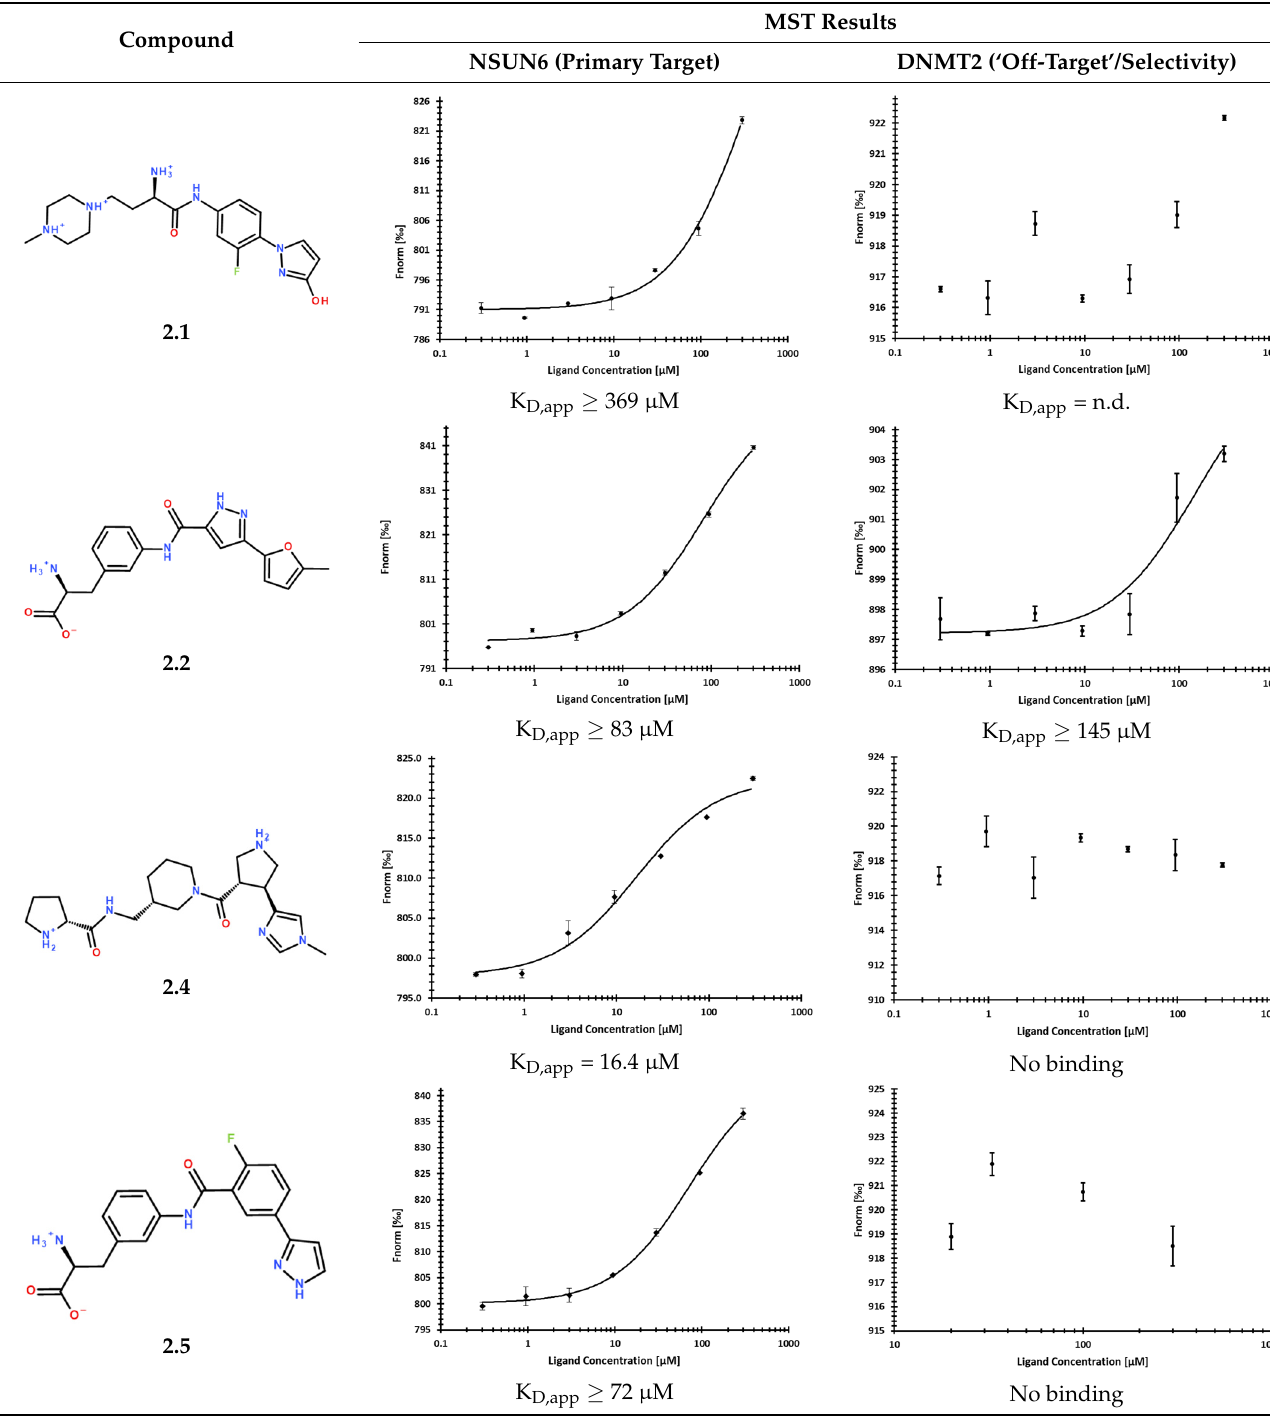
Table 3. MST results of newly identified NSUN6-ligands derived from the NSUN6 virtual screening. Table 3. MST results of newly identi fi ed NSUN6-ligands derived from the NSUN6 virtual screening. Table 3. MST results of newly identi fi ed NSUN6-ligands derived from the NSUN6 virtual screening. Table 3. MST results of newly identi fi ed NSUN6-ligands derived from the NSUN6 virtual screening. Table 3. MST results of newly identi fi ed NSUN6-ligands derived from the NSUN6 virtual screening. Table 3. MST results of newly identi fi ed NSUN6-ligands derived from the NSUN6 virtual screening. Table 3. MST results of newly identi fi ed NSUN6-ligands derived from the NSUN6 virtual screening. Measured normalized fluorescence values (Fnorm [‰]) are mean with standard error of at least Table 3. MST results of newly identi fi ed NSUN6-ligands derived from the NSUN6 virtual screening. Table 3. MST results of newly identi fi ed NSUN6-ligands derived from the NSUN6 virtual screening. Table 3. MST results of newly identi fi ed NSUN6-ligands derived from the NSUN6 virtual screening. Table 3. MST results of newly identi fi ed NSUN6-ligands derived from the NSUN6 virtual screening. Table 3. MST results of newly identi fi ed NSUN6-ligands derived from the NSUN6 virtual screening. Table 3. MST results of newly identi fi ed NSUN6-ligands derived from the NSUN6 virtual screening. Measured normalized fl uorescence values (Fnorm [‰]) are mean with standard error of at least Measured normalized fl uorescence values (Fnorm [‰]) are mean with standard error of at least Measured normalized fl uorescence values (Fnorm [‰]) are mean with standard error of at least Measured normalized fl uorescence values (Fnorm [‰]) are mean with standard error of at least Measured normalized fl uorescence values (Fnorm [‰]) are mean with standard error of at least Measured normalized fl uorescence values (Fnorm [‰]) are mean with standard error of at least duplicate determination. Apparent K D values (K D,app ) are indicated as a lower limit (via the ≥ Measured normalized fl uorescence values (Fnorm [‰]) are mean with standard error of at least Measured normalized fl uorescence values (Fnorm [‰]) are mean with standard error of at least Measured normalized fl uorescence values (Fnorm [‰]) are mean with standard error of at least Measured normalized fl uorescence values (Fnorm [‰]) are mean with standard error of at least Measured normalized fl uorescence values (Fnorm [‰]) are mean with standard error of at least Measured normalized fl uorescence values (Fnorm [‰]) are mean with standard error of at least duplicate determination. Apparent K D values (K D,app ) are indicated as a lower limit (via the ≥ symbol) duplicate determination. Apparent K D values (K D,app ) are indicated as a lower limit (via the ≥ symbol) duplicate determination. Apparent K D values (K D,app ) are indicated as a lower limit (via the ≥ symbol) duplicate determination. Apparent K D values (K D,app ) are indicated as a lower limit (via the ≥ symbol) duplicate determination. Apparent K D values (K D,app ) are indicated as a lower limit (via the ≥ symbol) duplicate determination. Apparent K D values (K D,app ) are indicated as a lower limit (via the ≥ symbol) duplicate determination. Apparent K D values (K D,app ) are indicated as a lower limit (via the ≥ symbol) duplicate determination. Apparent K D values (K D,app ) are indicated as a lower limit (via the ≥ symbol) duplicate determination. Apparent K D values (K D,app ) are indicated as a lower limit (via the ≥ symbol) symbol) if the upper plateau of the dose–response curve was not completely reached. In case a duplicate determination. Apparent K D values (K D,app ) are indicated as a lower limit (via the ≥ symbol) duplicate determination. Apparent K D values (K D,app ) are indicated as a lower limit (via the ≥ symbol) duplicate determination. Apparent K D values (K D,app ) are indicated as a lower limit (via the ≥ symbol) if the upper plateau of the dose–response curve was not completely reached. In case a dose-depend- if the upper plateau of the dose–response curve was not completely reached. In case a dose-depend- if the upper plateau of the dose–response curve was not completely reached. In case a dose-depend- if the upper plateau of the dose–response curve was not completely reached. In case a dose-depend- if the upper plateau of the dose–response curve was not completely reached. In case a dose-depend- if the upper plateau of the dose–response curve was not completely reached. In case a dose-depend- if the upper plateau of the dose–response curve was not completely reached. In case a dose-depend- if the upper plateau of the dose–response curve was not completely reached. In case a dose-depend- if the upper plateau of the dose–response curve was not completely reached. In case a dose-depend- dose-dependent shift in thermophoresis was observed, which indicates binding, but the curve could if the upper plateau of the dose–response curve was not completely reached. In case a dose-depend- if the upper plateau of the dose–response curve was not completely reached. In case a dose-depend- if the upper plateau of the dose–response curve was not completely reached. In case a dose-depend- ent shift in thermophoresis was observed, which indicates binding, but the curve could not be fi tt ed ent shift in thermophoresis was observed, which indicates binding, but the curve could not be fi tt ed ent shift in thermophoresis was observed, which indicates binding, but the curve could not be fi tt ed ent shift in thermophoresis was observed, which indicates binding, but the curve could not be fi tt ed ent shift in thermophoresis was observed, which indicates binding, but the curve could not be fi tt ed ent shift in thermophoresis was observed, which indicates binding, but the curve could not be fi tt ed ent shift in thermophoresis was observed, which indicates binding, but the curve could not be fi tt ed ent shift in thermophoresis was observed, which indicates binding, but the curve could not be fi tt ed ent shift in thermophoresis was observed, which indicates binding, but the curve could not be fi tt ed ent shift in thermophoresis was observed, which indicates binding, but the curve could not be fi tt ed ent shift in thermophoresis was observed, which indicates binding, but the curve could not be fi tt ed ent shift in thermophoresis was observed, which indicates binding, but the curve could not be fi tt ed not be fitted with sufficient accuracy, K D,app was not determined (n.d.). Molecules are depicted in with su ffi cient accuracy, K D,app was not determined (n.d.). Molecules are depicted in their docked with su ffi cient accuracy, K D,app was not determined (n.d.). Molecules are depicted in their docked with su ffi cient accuracy, K D,app was not determined (n.d.). Molecules are depicted in their docked with su ffi cient accuracy, K D,app was not determined (n.d.). Molecules are depicted in their docked with su ffi cient accuracy, K D,app was not determined (n.d.). Molecules are depicted in their docked with su ffi cient accuracy, K D,app was not determined (n.d.). Molecules are depicted in their docked with su ffi cient accuracy, K D,app was not determined (n.d.). Molecules are depicted in their docked with su ffi cient accuracy, K D,app was not determined (n.d.). Molecules are depicted in their docked with su ffi cient accuracy, K D,app was not determined (n.d.). Molecules are depicted in their docked with su ffi cient accuracy, K D,app was not determined (n.d.). Molecules are depicted in their docked with su ffi cient accuracy, K D,app was not determined (n.d.). Molecules are depicted in their docked with su ffi cient accuracy, K D,app was not determined (n.d.). Molecules are depicted in their docked their docked stereoisomers, protomers, and tautomers; however, for 2.1 and 2.4 , racemic mixtures stereoisomers, protomers, and tautomers; however, for 2.1 and 2.4 , racemic mixtures were obtained stereoisomers, protomers, and tautomers; however, for 2.1 and 2.4 , racemic mixtures were obtained stereoisomers, protomers, and tautomers; however, for 2.1 and 2.4 , racemic mixtures were obtained stereoisomers, protomers, and tautomers; however, for 2.1 and 2.4 , racemic mixtures were obtained stereoisomers, protomers, and tautomers; however, for 2.1 and 2.4 , racemic mixtures were obtained stereoisomers, protomers, and tautomers; however, for 2.1 and 2.4 , racemic mixtures were obtained stereoisomers, protomers, and tautomers; however, for 2.1 and 2.4 , racemic mixtures were obtained stereoisomers, protomers, and tautomers; however, for 2.1 and 2.4 , racemic mixtures were obtained stereoisomers, protomers, and tautomers; however, for 2.1 and 2.4 , racemic mixtures were obtained stereoisomers, protomers, and tautomers; however, for 2.1 and 2.4 , racemic mixtures were obtained stereoisomers, protomers, and tautomers; however, for 2.1 and 2.4 , racemic mixtures were obtained stereoisomers, protomers, and tautomers; however, for 2.1 and 2.4 , racemic mixtures were obtained for testing. All molecules are drawn in the same orientation as SAH, with left side: amino acid mi- for testing. All molecules are drawn in the same orientation as SAH, with left side: amino acid mi- for testing. All molecules are drawn in the same orientation as SAH, with left side: amino acid mi- were obtained for testing. All molecules are drawn in the same orientation as SAH, with left side: for testing. All molecules are drawn in the same orientation as SAH, with left side: amino acid mi- for testing. All molecules are drawn in the same orientation as SAH, with left side: amino acid mi- for testing. All molecules are drawn in the same orientation as SAH, with left side: amino acid mi- for testing. All molecules are drawn in the same orientation as SAH, with left side: amino acid mi- for testing. All molecules are drawn in the same orientation as SAH, with left side: amino acid mi- for testing. All molecules are drawn in the same orientation as SAH, with left side: amino acid mi- for testing. All molecules are drawn in the same orientation as SAH, with left side: amino acid mi- for testing. All molecules are drawn in the same orientation as SAH, with left side: amino acid mi- for testing. All molecules are drawn in the same orientation as SAH, with left side: amino acid mi- metic, central part: ribose replacement, right side: adenine mimetic. metic, central part: ribose replacement, right side: adenine mimetic. metic, central part: ribose replacement, right side: adenine metic, central part: ribose replacement, right side: adenine mimetic. amino acid mimetic, central part: ribose replacement, right side: adenine mimetic. metic, central part: ribose replacement, right side: adenine mimetic. metic, central part: ribose replacement, right side: adenine mimetic. metic, central part: ribose replacement, right side: adenine mimetic. metic, central part: ribose replacement, right side: adenine mimetic. metic, central part: ribose replacement, right side: adenine mimetic. metic, central part: ribose replacement, right side: adenine mimetic. metic, central part: ribose replacement, right side: adenine mimetic. metic, central part: ribose replacement, right side: adenine mimetic.